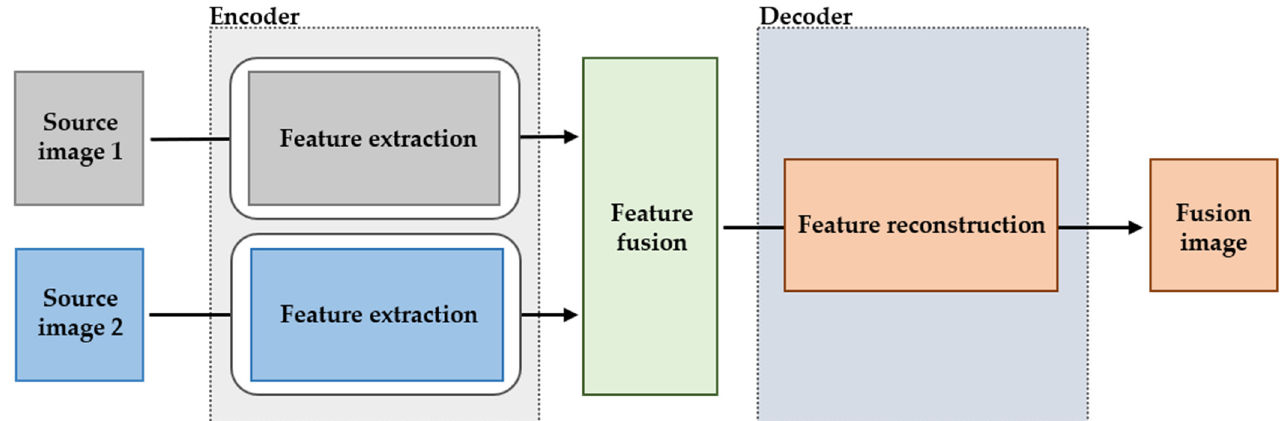
Figure 2. Traditional deep-learning-based image fusion structure.